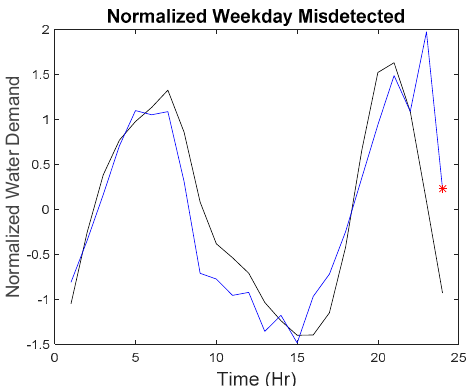
Figure 21. Shape of series with fourth missed detected anomaly.